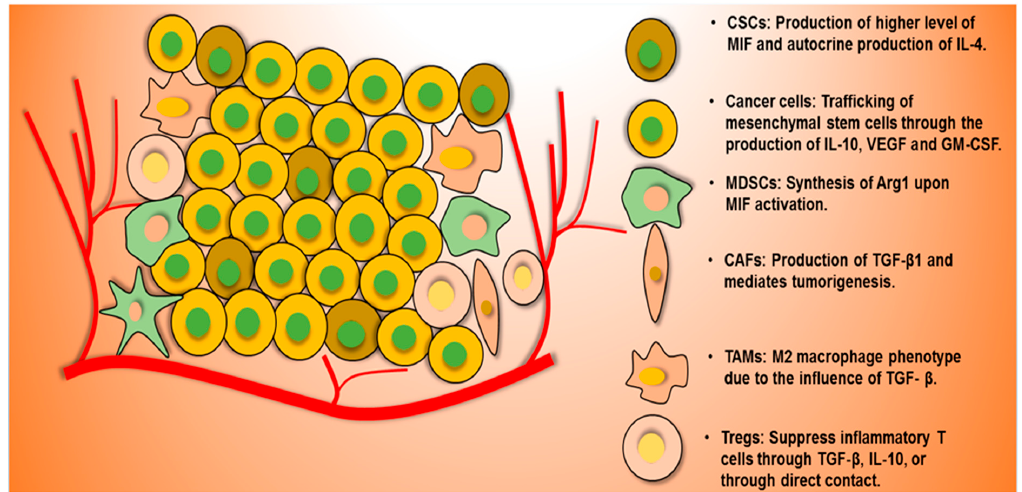
Figure 1. General roles of CSCs and other cells in tumor microenvironment (TME) and the mechanisms of immune escaping, and tumorigenesis. CSCs produces of higher level of migration inhibitory factor (MIF) and autocrine production of IL-4 in order to escape macrophage killing. Cancer cells produce IL-10, VEGF, and GM-CSF, which are involved in trafficking of mesenchymal stem cells. Myeloid derived suppressor cells (MDSCs) secrete Arg1 through MIF1 activation. CAFs mediate tumorigenesis through TGF- β . M2 macrophage promotes tumorigenesis for TGF- β response. TGF- β and IL-10 of T-regulatory cells suppress T-effector cells. (Abbreviations: CAFs, cancer-associated fibroblasts; CSC, cancer stem cells; FAS, fas cell surface death receptor; GM-CSF, granulocyte-macrophage colony-stimulating factor; IL-10, interleukin-10; MDSCs, myeloid-derived suppressor cells, TGF- β , tumor growth factor-beta; VEGF, vascular endothelial growth factor). Table 2. Immune resistance of CSCs and their mechanism in various cancers.